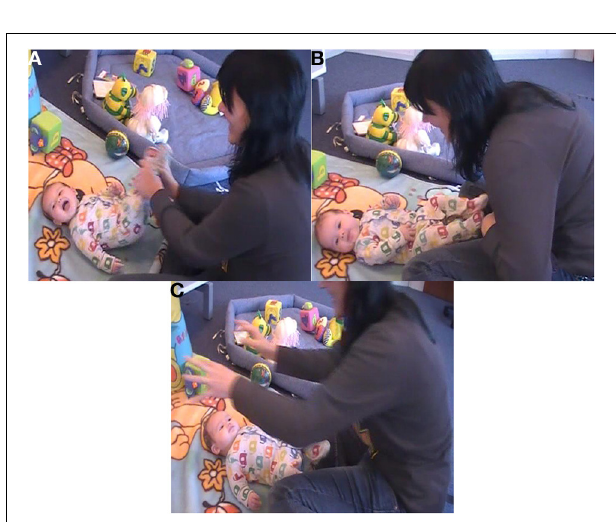
movements of both the arms and the legs simultaneously, whereas a score of 1 indicate a single movement of either the arms or the legs. A score of 0 indicate absence of movement.